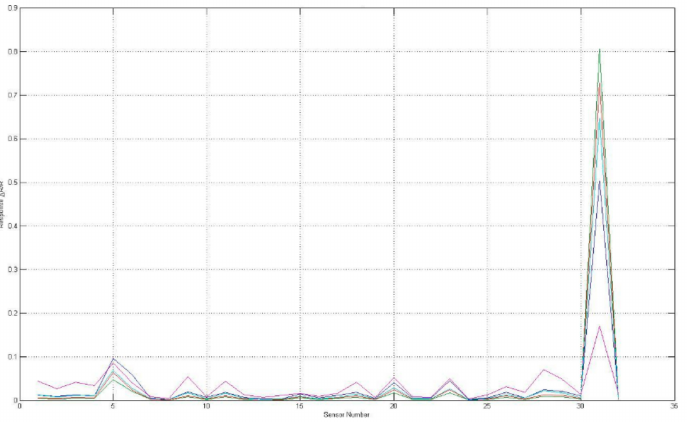
Figure 4. Sensorgram of the sensors’ responses to F-MC made with milk from Jersey cows (SMF).